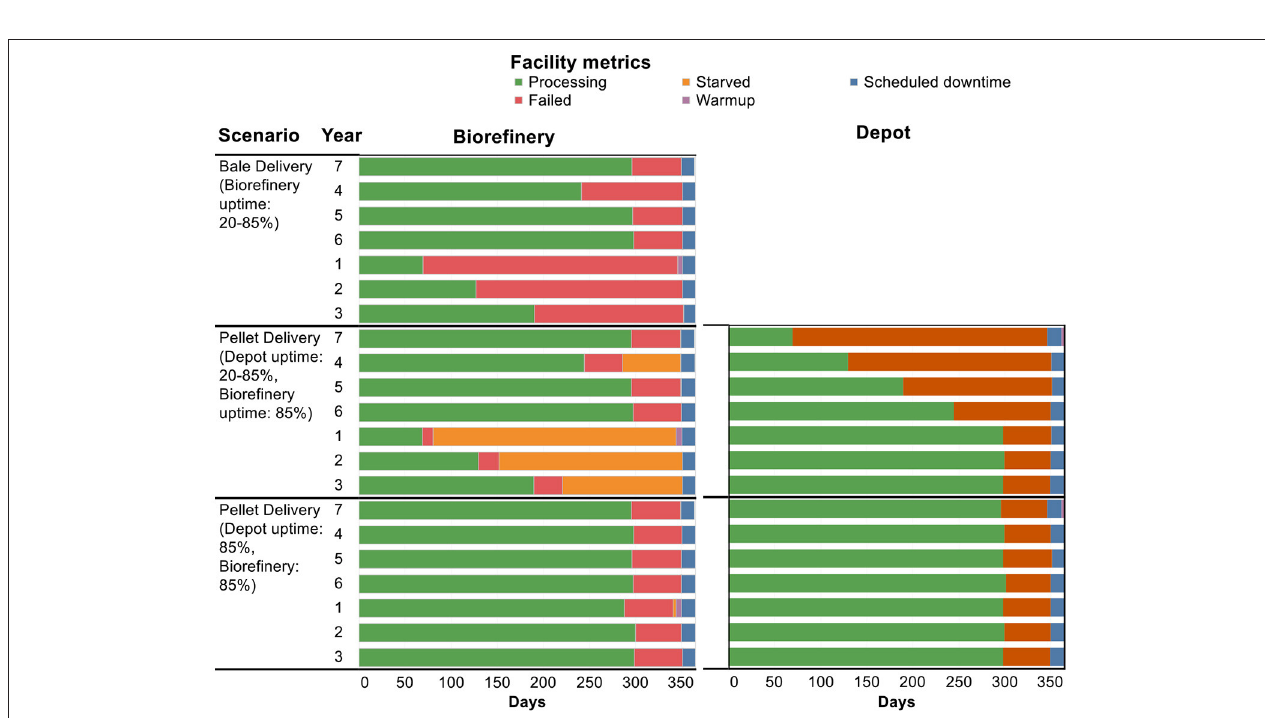
FIGURE 10 | Facility metrics for the bale-delivery (Biorefinery uptime: 20–85%), pellet-delivery (Depot uptime: 20–85%, Biorefinery uptime: 85%) and pellet-delivery (Depot uptime: 85%, Biorefinery uptime: 85%).